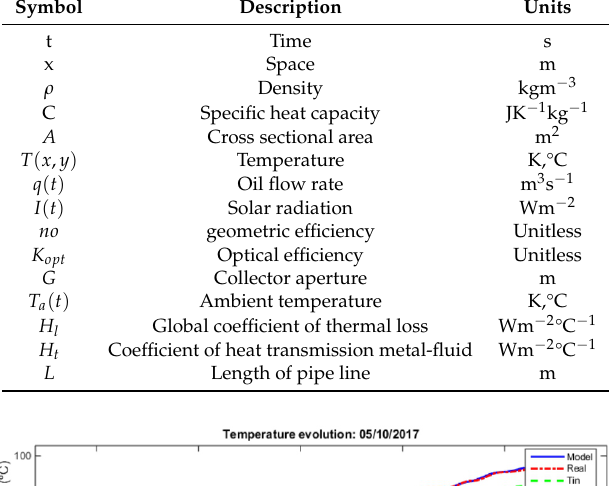
Table 1. Parameter description.